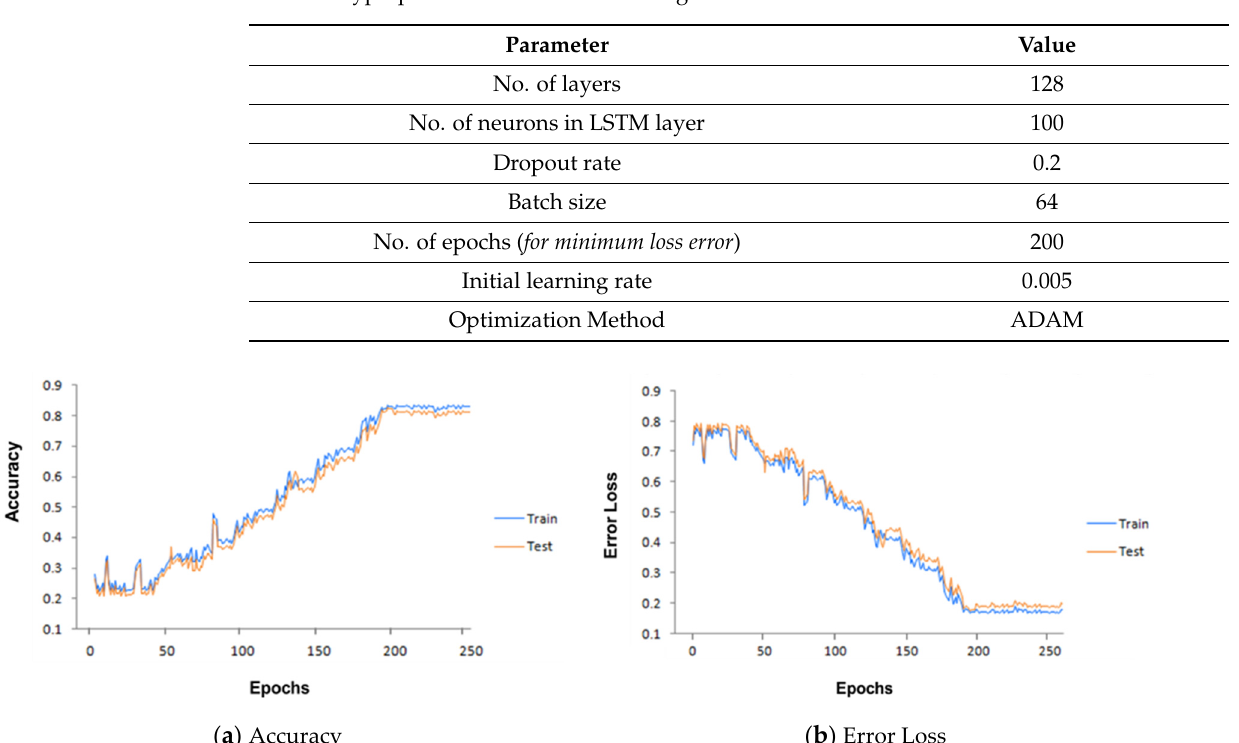
Figure 3. Snapshot of a part of core I-RBAC ontology. Table 2. Hyperparameter values for training of our Bi-LSTM.